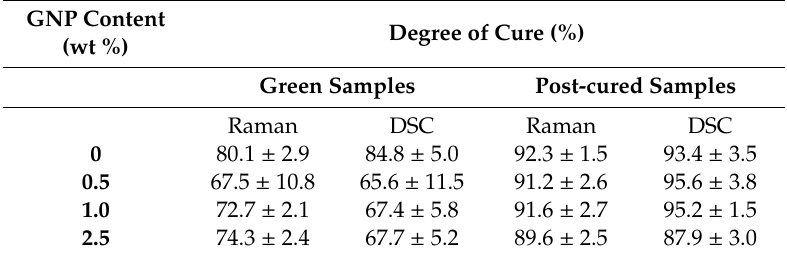
Figure 5. a ) Differential scanning calorimetry (DSC) thermograms of the non-cured, green and post-cured resins containing 0–2.5 wt % GNP; b ) amount of resin cured obtained from the DSC results as a function of the GNP content for the green and post-cured samples. Table 1. Summary of the degrees of cure determined via the Raman spectroscopy and DSC for the green and post-cured nanocomposites containing 0–2.5 wt % GNP.